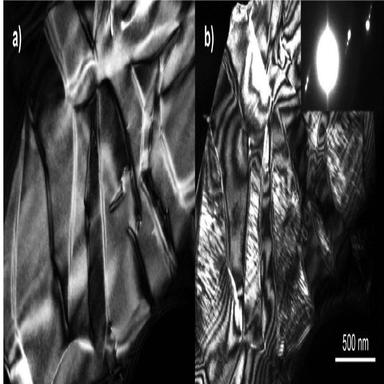
Dark field image of the domain structure; (a) strong beam diffraction condition showing domain contrast only; (b) weaker diffraction condition showing nanostructure in one set of domains.